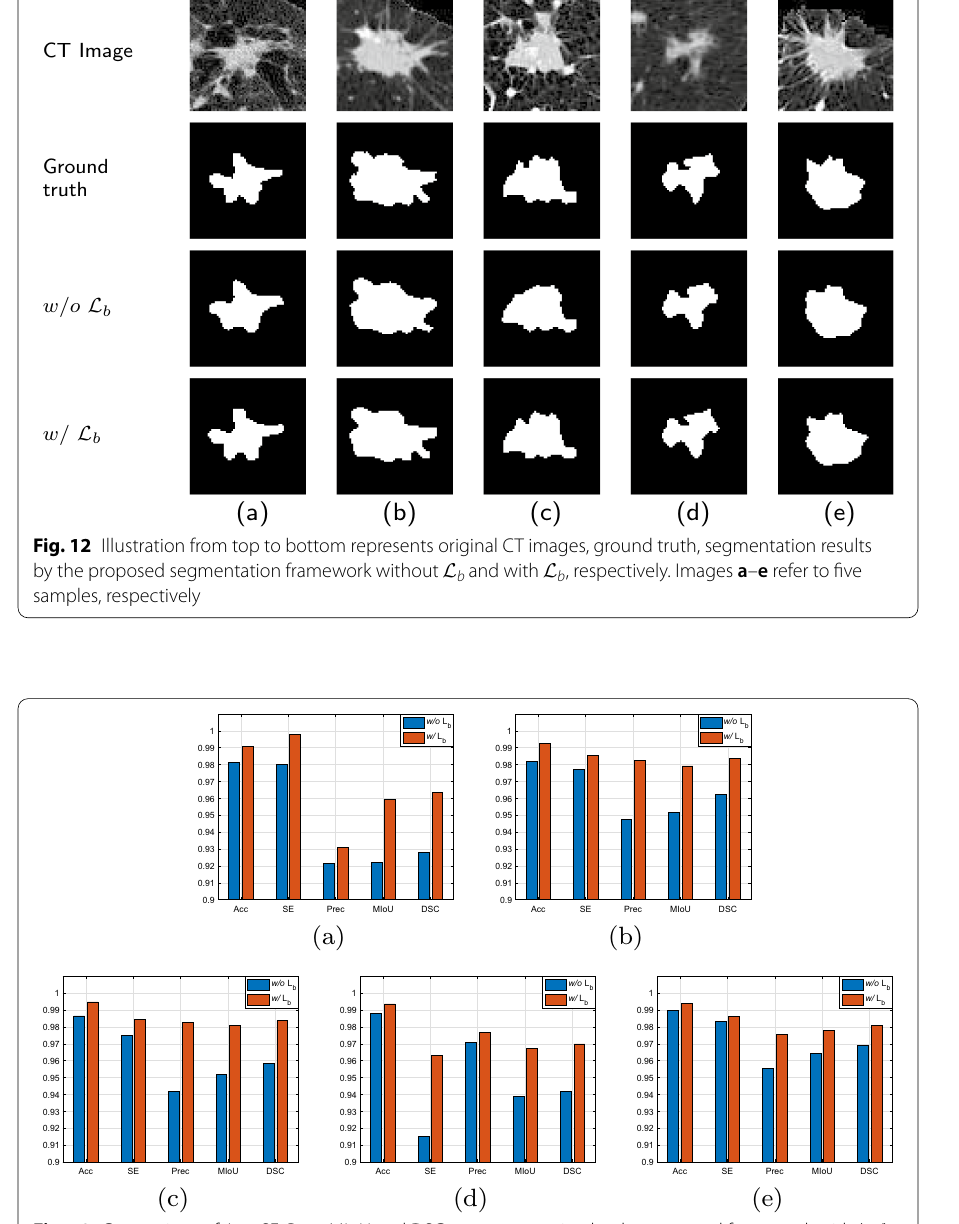
Fig. 13 Comparison of Acc, SE, Prec, MIoU and DSC on segmentation by the proposed framework with ( w /) and without ( w / o ) L b . Graphs a – e correspond to same images illustrated in